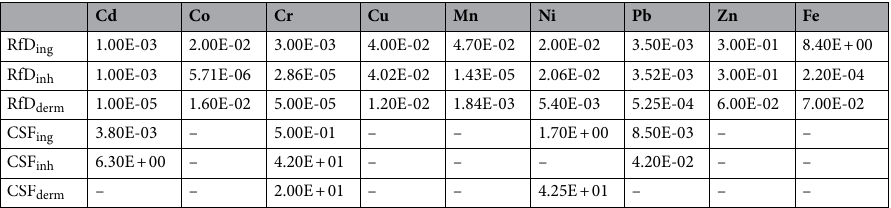
Table 2. Rfd and CSF values used for health risk assessment in this study 70–72